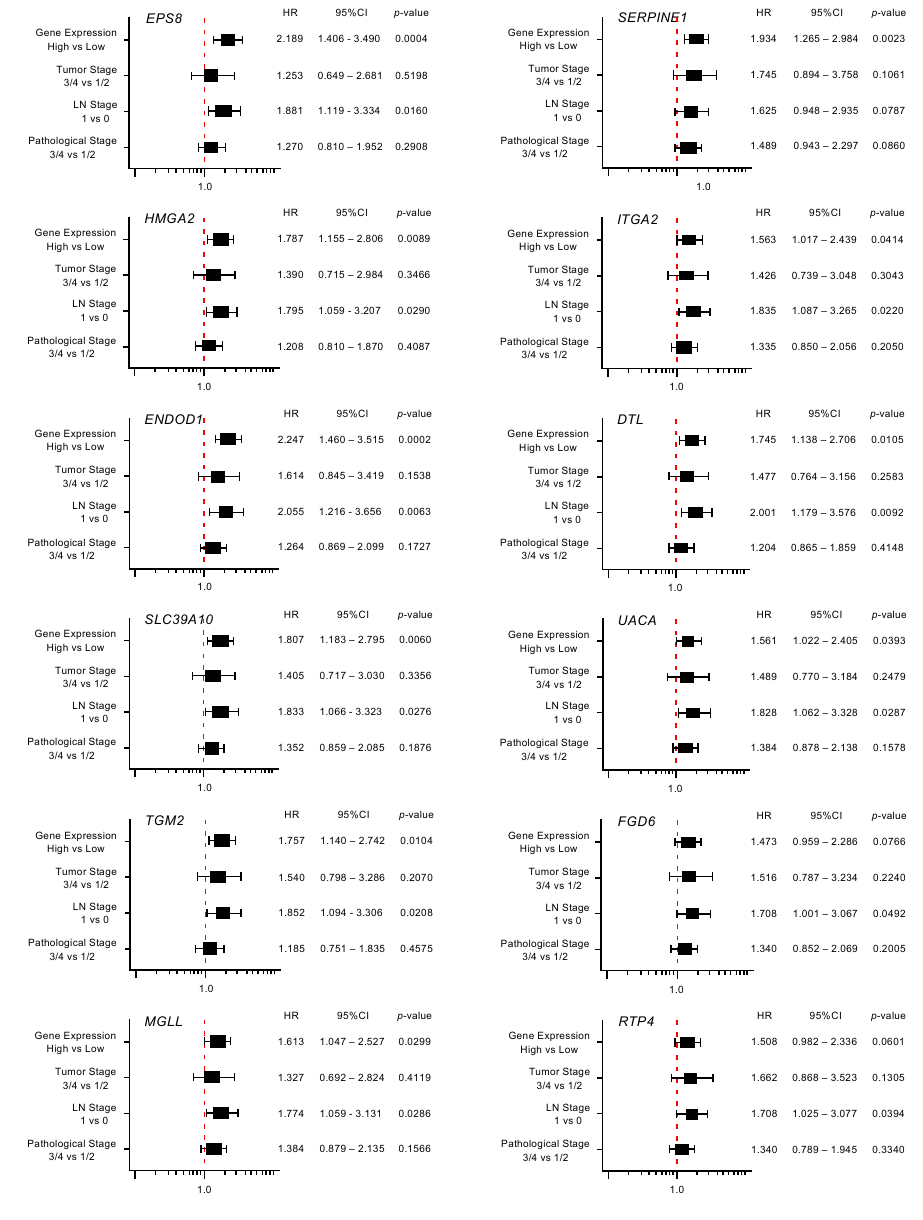
Figure 4. Forest plot of the multivariate analysis of the 12 genes that are targets of miR-30a-3p regulation (predicted 5-year survival).